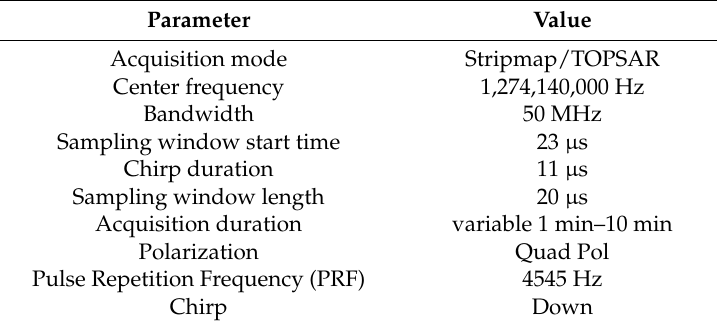
Table 3. SAOCOM 1A acquisition parameters for outdoor